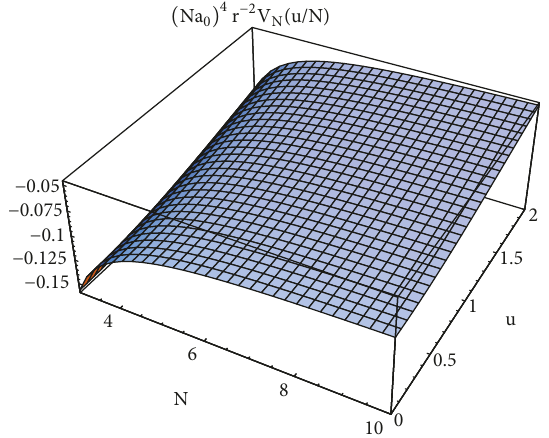
Figure6:Thenumericalresultsfor (𝑁𝑎 0 ) 4 𝑟 −2 𝑉 푁 (𝑢/𝑁) asafunction of 𝑁 and 𝑢